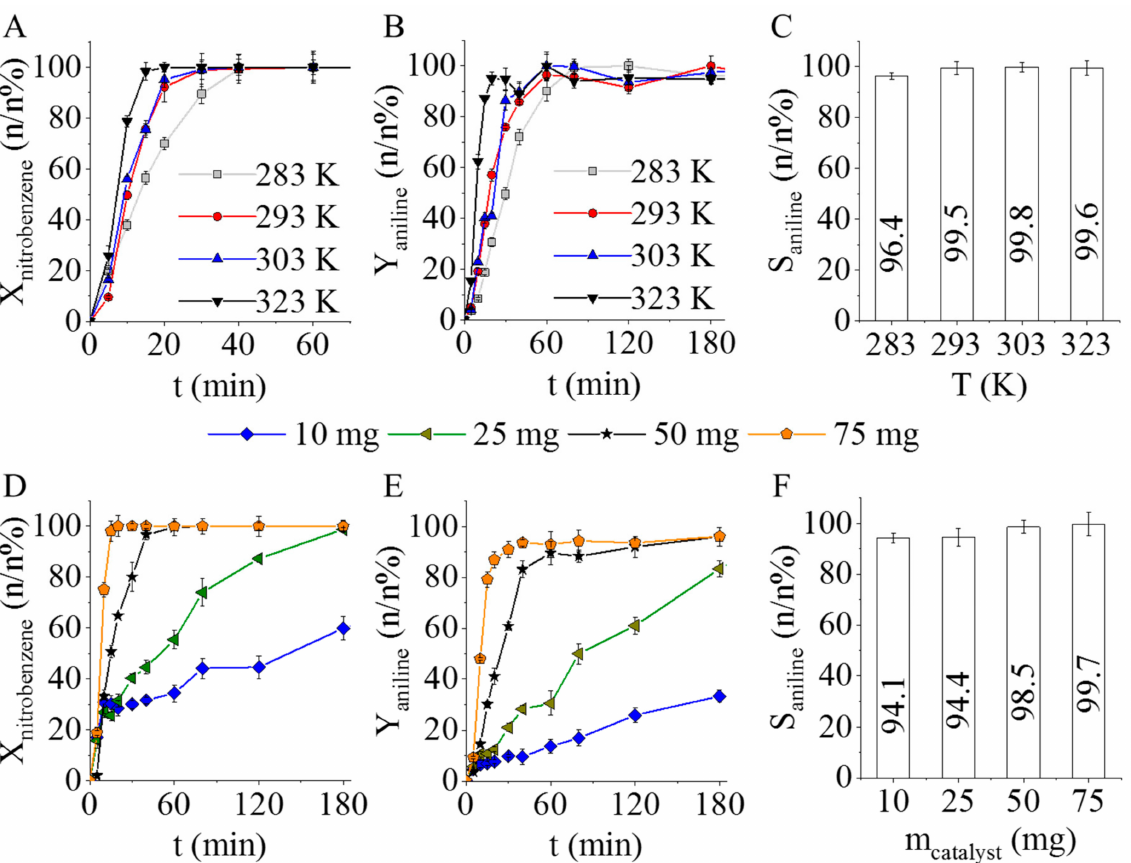
Figure 5. Nitrobenzene conversion ( A ) and aniline yield ( B ) vs. hydrogenation time, and aniline selectivity at four different temperatures after 60 min hydrogenation ( C ) by using 100 mg of Pd/CF catalyst. Nitrobenzene conversion ( D ) and aniline yield vs. hydrogenation time ( E ), and aniline selectivity ( F ) by using of 10 mg, 25 mg, 50 mg, and 75 mg catalyst after 60 min hydrogenation. After 60 min of hydrogenation, the total amount of nitrobenzene was converted to aniline, and the conversion was almost 100%. By increasing the reaction temperature,